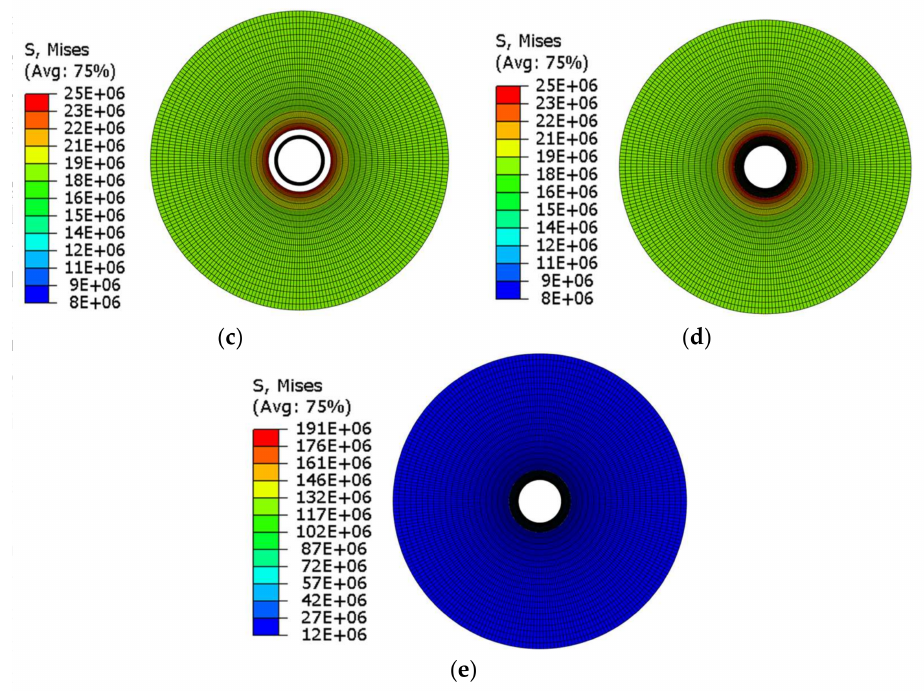
Figure 5. Schematic diagrams of the staged FEM analysis ( a ) Balancing stress field; ( b ) Drilling; ( c ) Inserting casing; ( d ) Cementing; ( e ) Hydraulic fracturing.